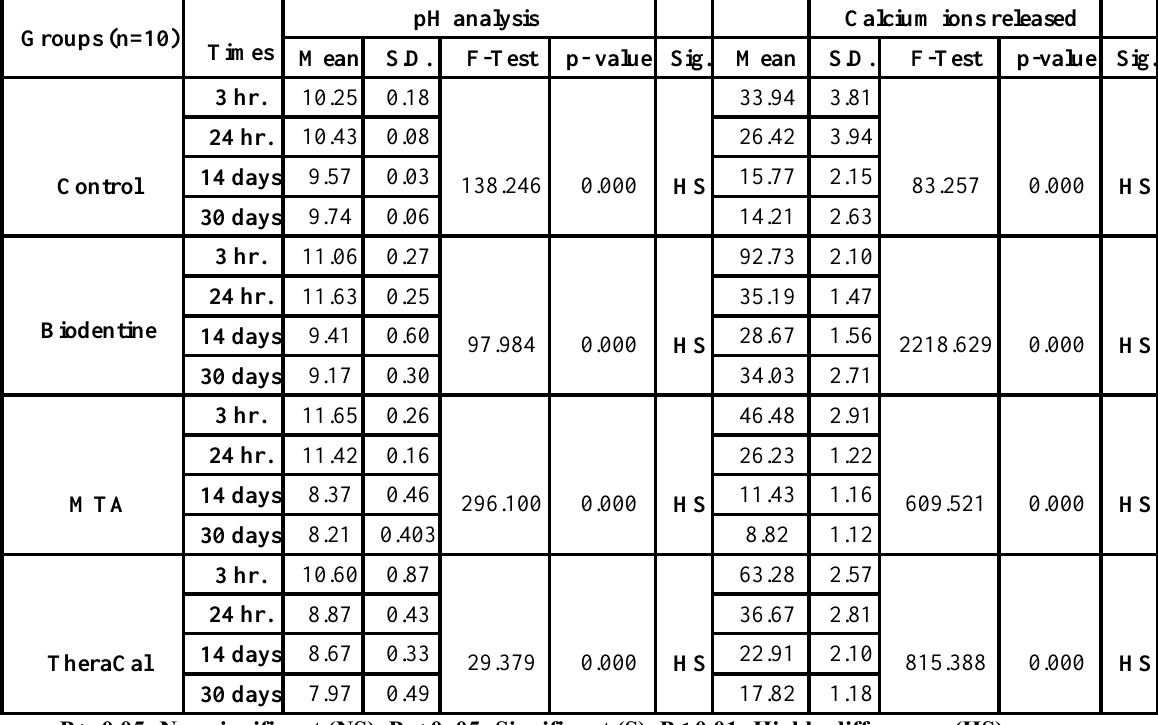
Table (2): Descriptive statistic for pH analysis and Calcium ions released with one-way ANOVA test among the subgroups of each group.